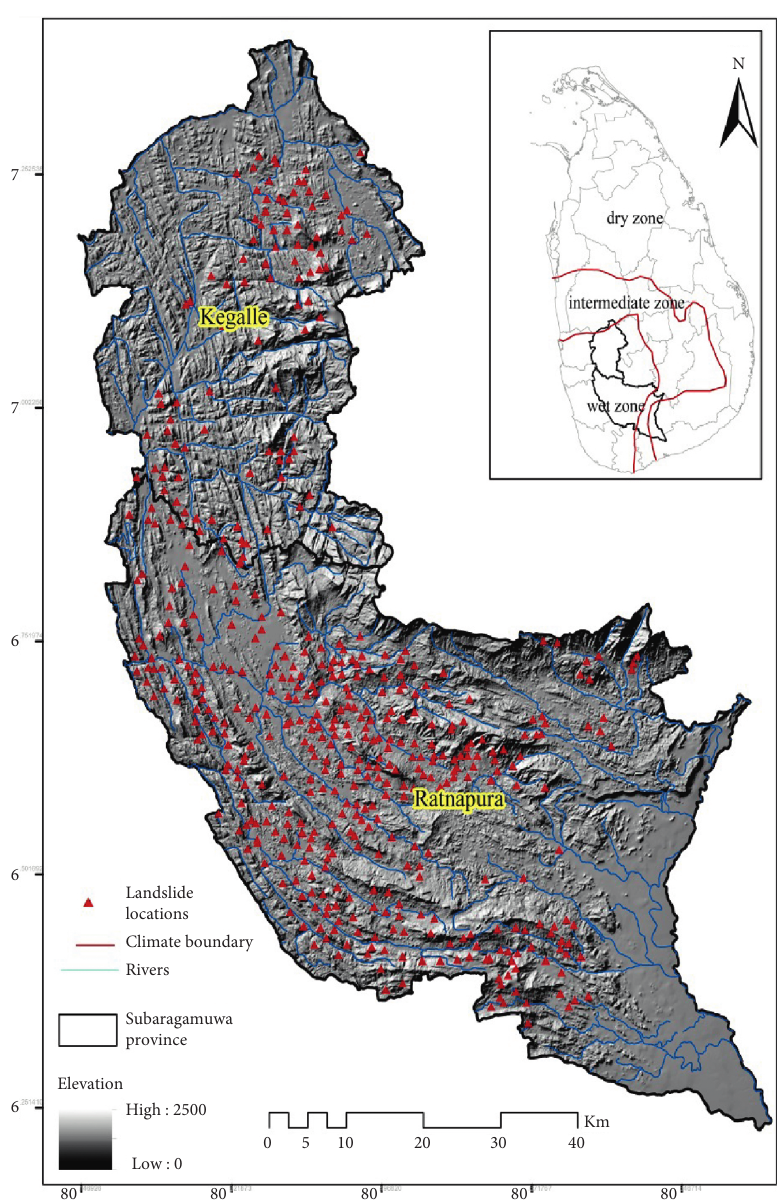
Figure 1: Geographical setting, landslide distribution, and elevation of the